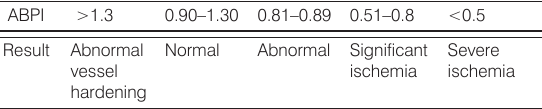
Table 2. Ankle–brachial pressure index (ABPI).